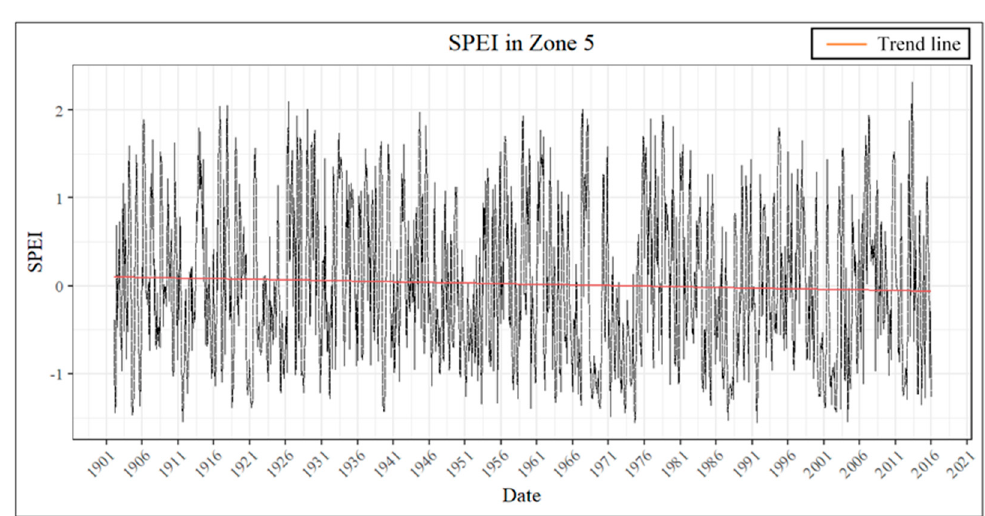
Figure 14. Three-month SPEI from 1902–2015 for zone 5.